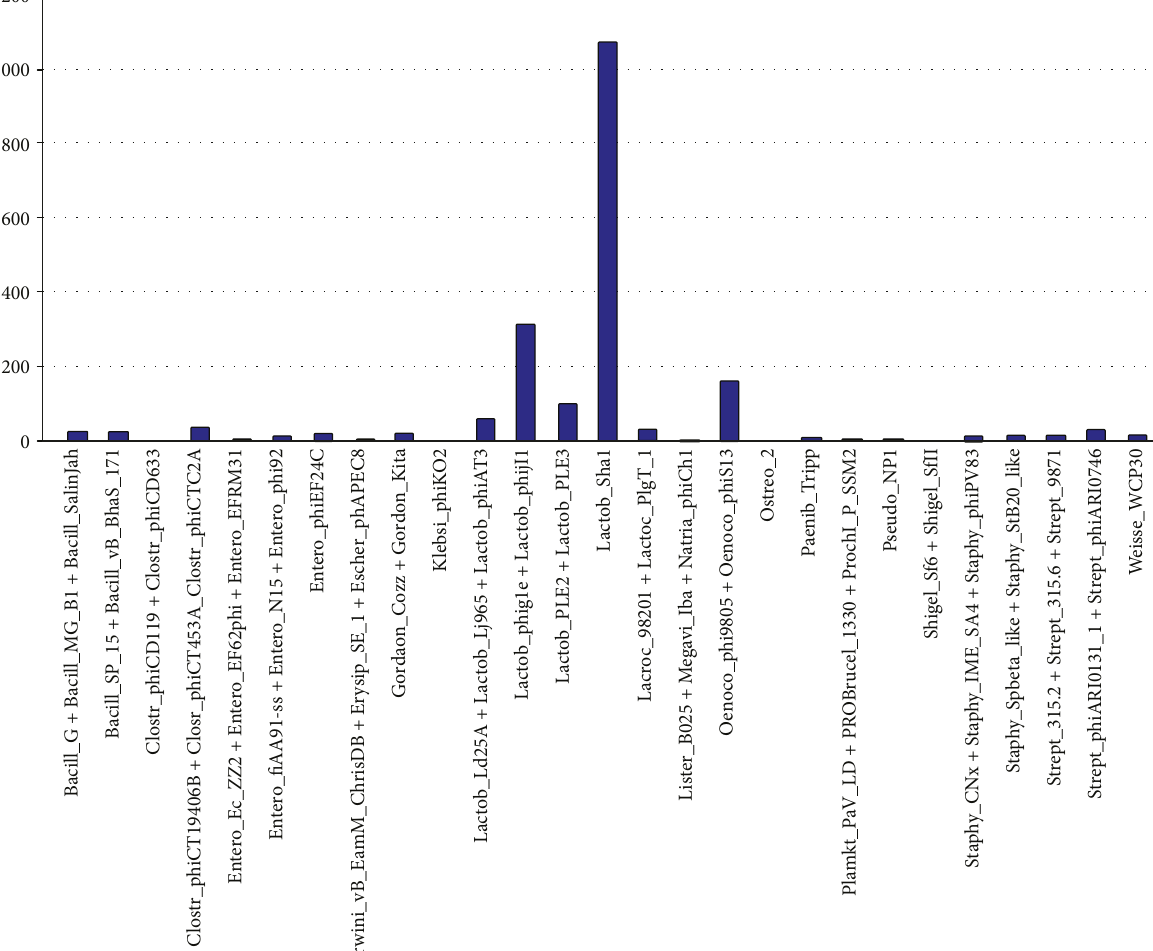
Figure 1: Types of prophage detected in L. plantarum